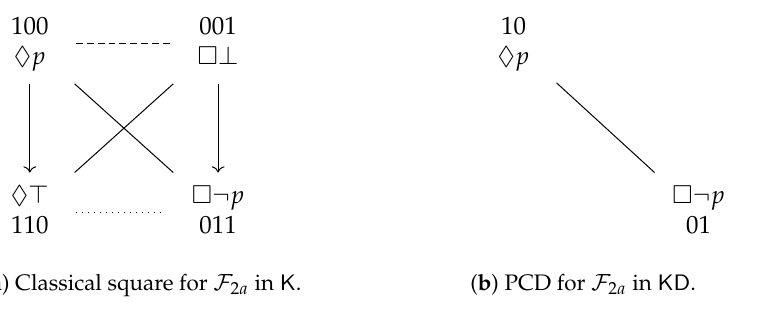
Figure 9. Aristotelian diagrams for F 2 a = { ♦ p , ♦ (cid:62) , (cid:3) ⊥ , (cid:3) ¬ p } in two normal modal logics.